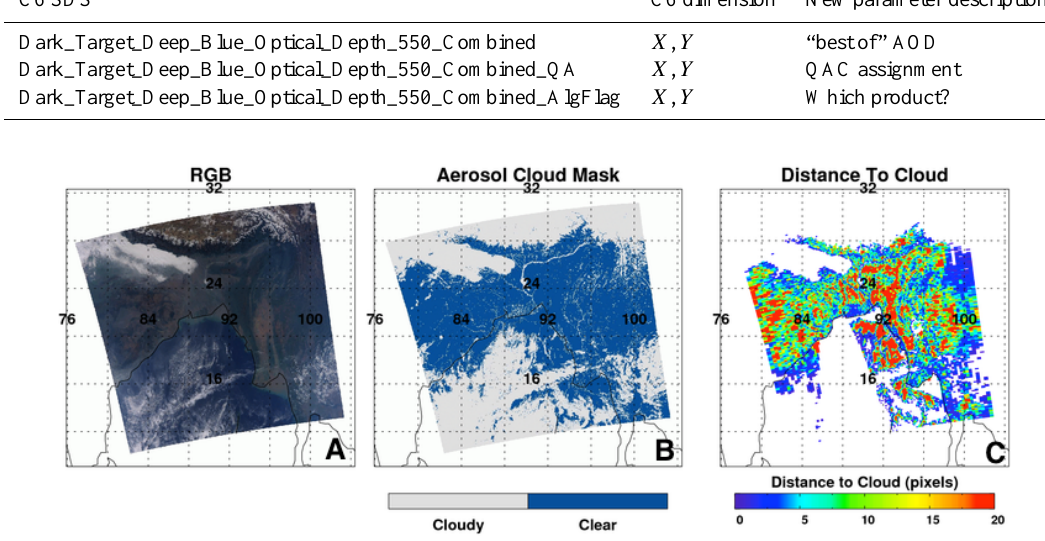
Fig. 18. New aerosol cloud mask variables, both from an AQUA granule on 3 January 2010 at 07:20UTC. (a) RGB, (b) Aerosol cloud mask. Figure 18: New aerosol cloud mask variables, both from an AQUA granule on 03 Jan 2010 at (c) Distance to cloud (in 07:20 UTC. [A]: RGB, [B]: Aerosol cloud mask. [C]: Distance to cloud (in pixels).